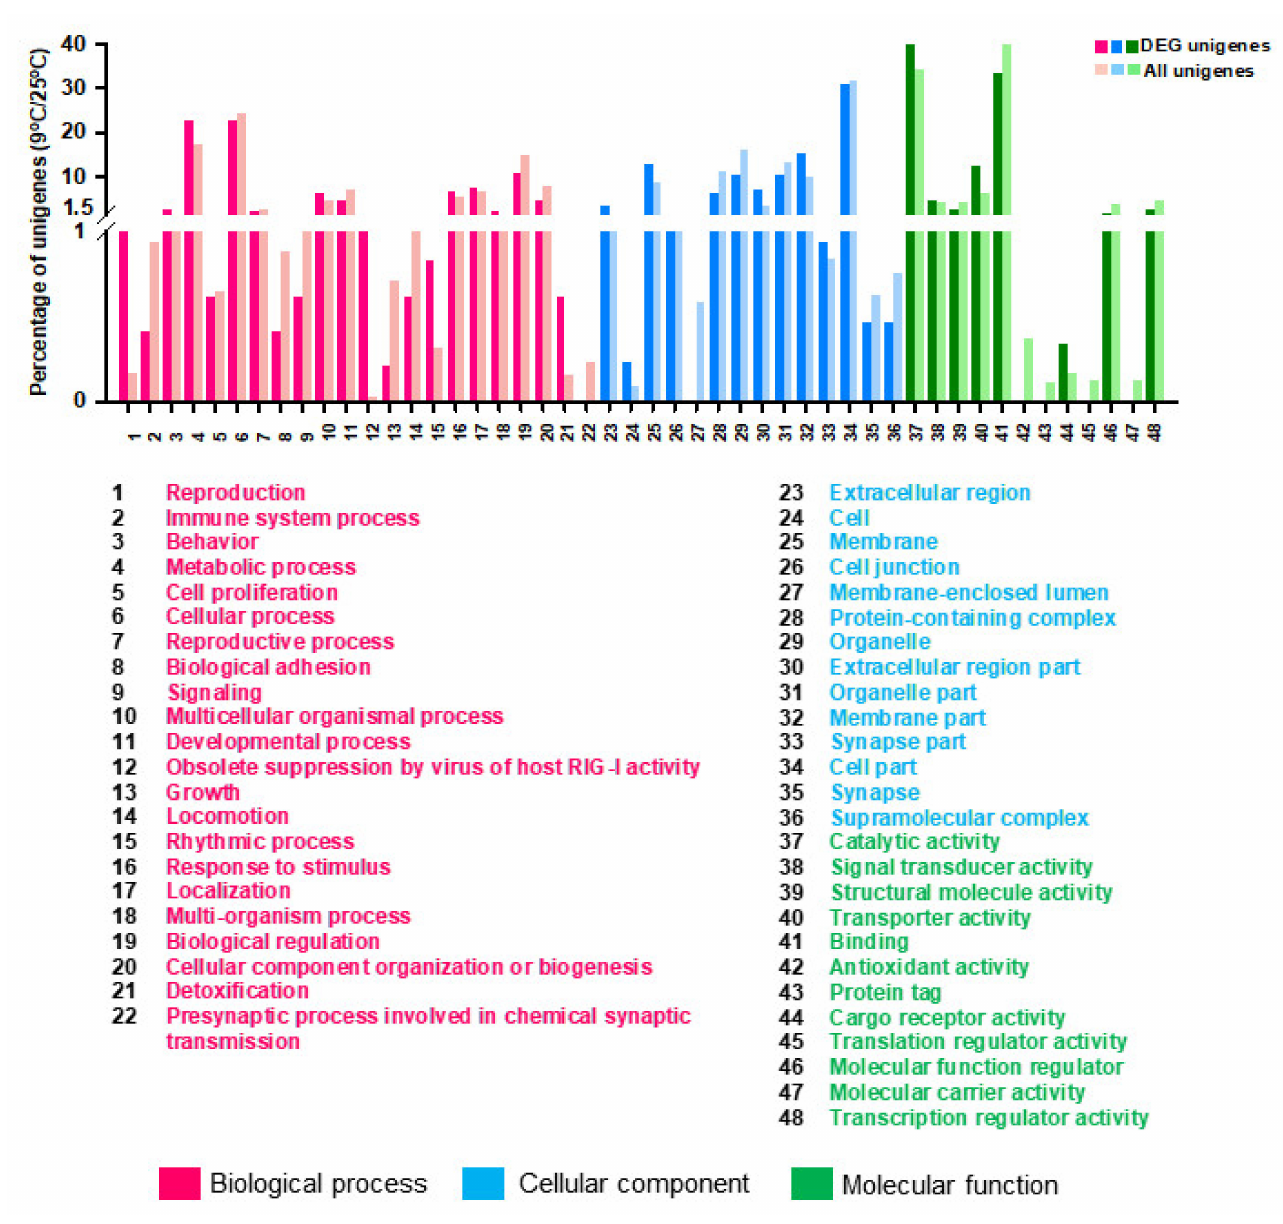
Figure 5. Gene Ontology (GO) annotations of the specific Differentially Expressed Genes (DEGs) ( p -value < 0.05, log 2 FC ≥ 1, ≤ − 1) coregulated by cold temperature stresses in comparison to all DEGs. Go terms are summarized in three main categories of ‘Biological process’, ‘Cellular component’ and ‘Molecular function’. The Y-axis shows the percentage of unigenes in each